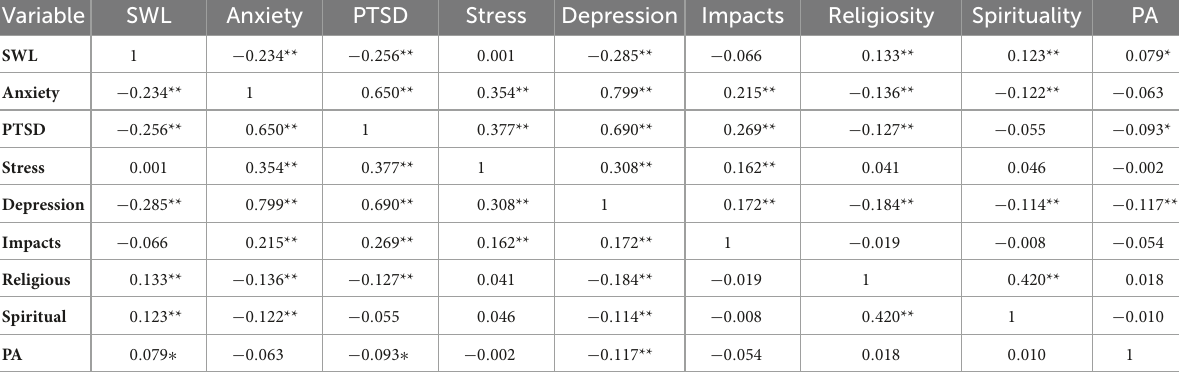
TABLE 3 Correlation matrix with Pearson’s r coefficient ( n = 754). Variable